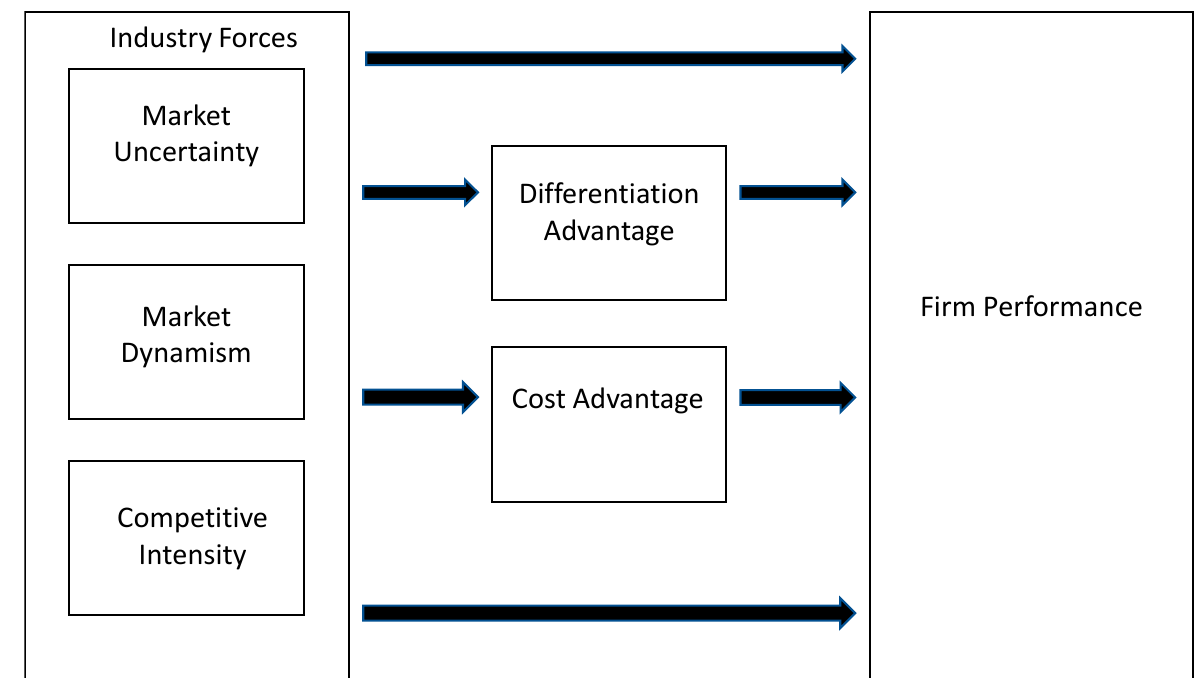
Figure 1. Research framework.